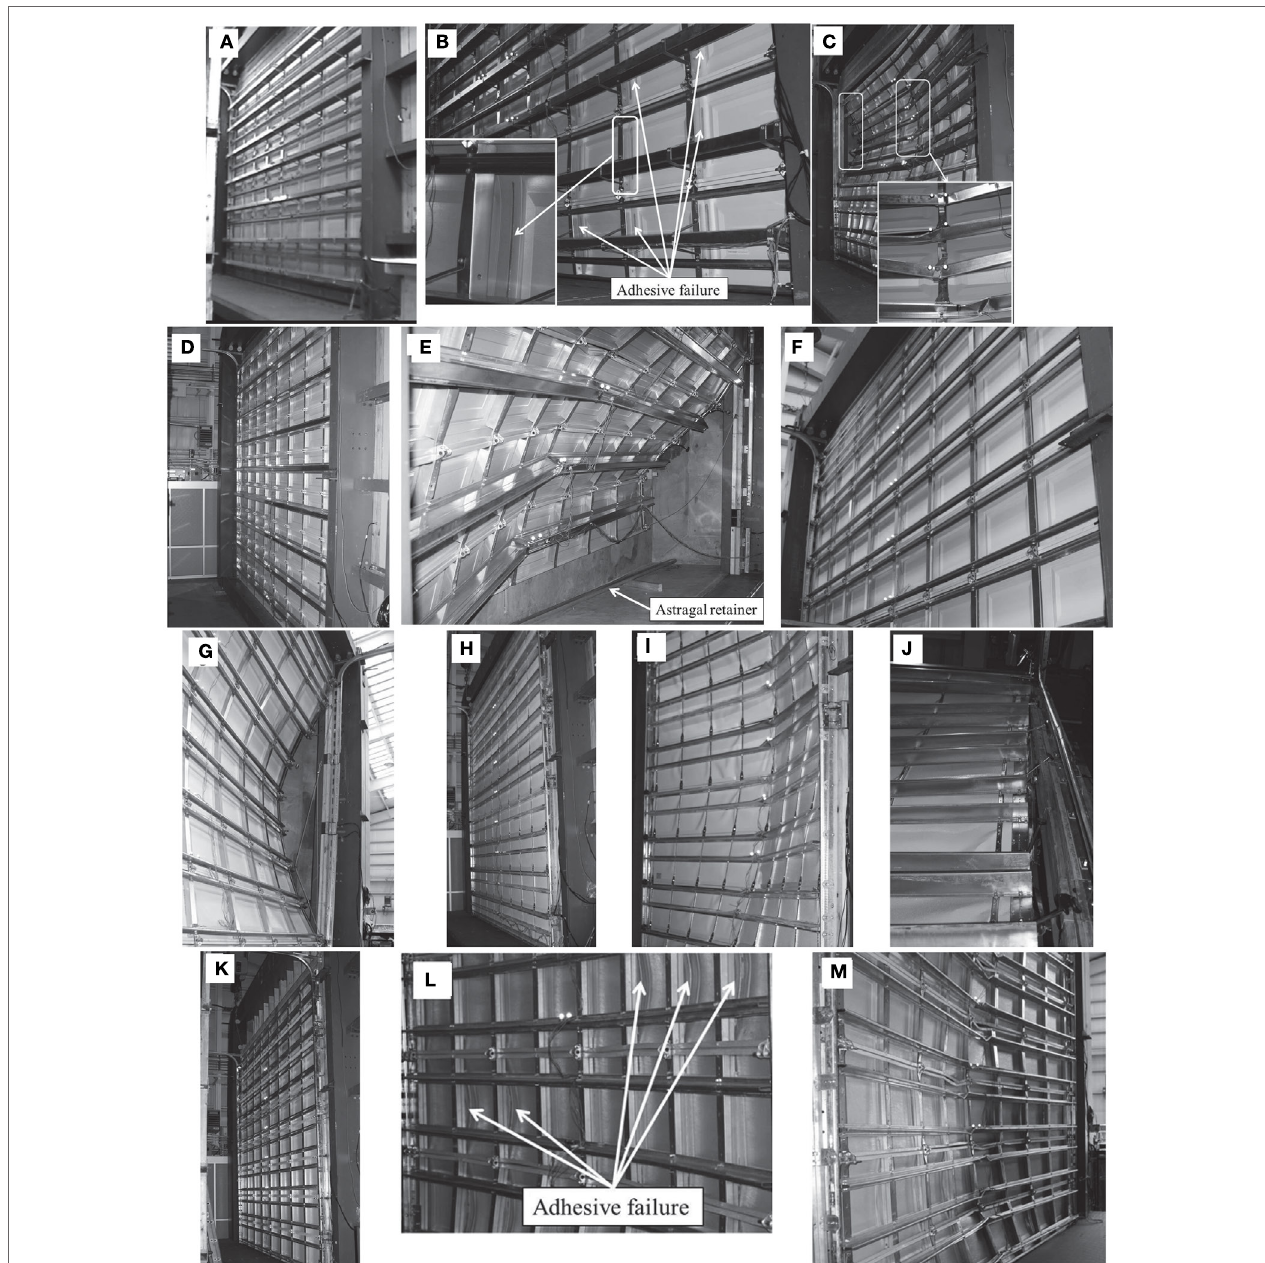
FigUre 8 | Door 1 (a) before testing, (B) at adhesive failure, and (c) at catastrophic failure; Door 2 (D) before testing and (e) at catastrophic failure; Door 3 (F) before testing and (g) at catastrophic failure; Door 4 (h) before testing, (i) at catastrophic failure showing local buckling of U-bars, and (J) at catastrophic failure showing disengagement of rollers from the tracks; and Door 5 (K) before testing, (l) at adhesive failure, and (M) at catastrophic failure .